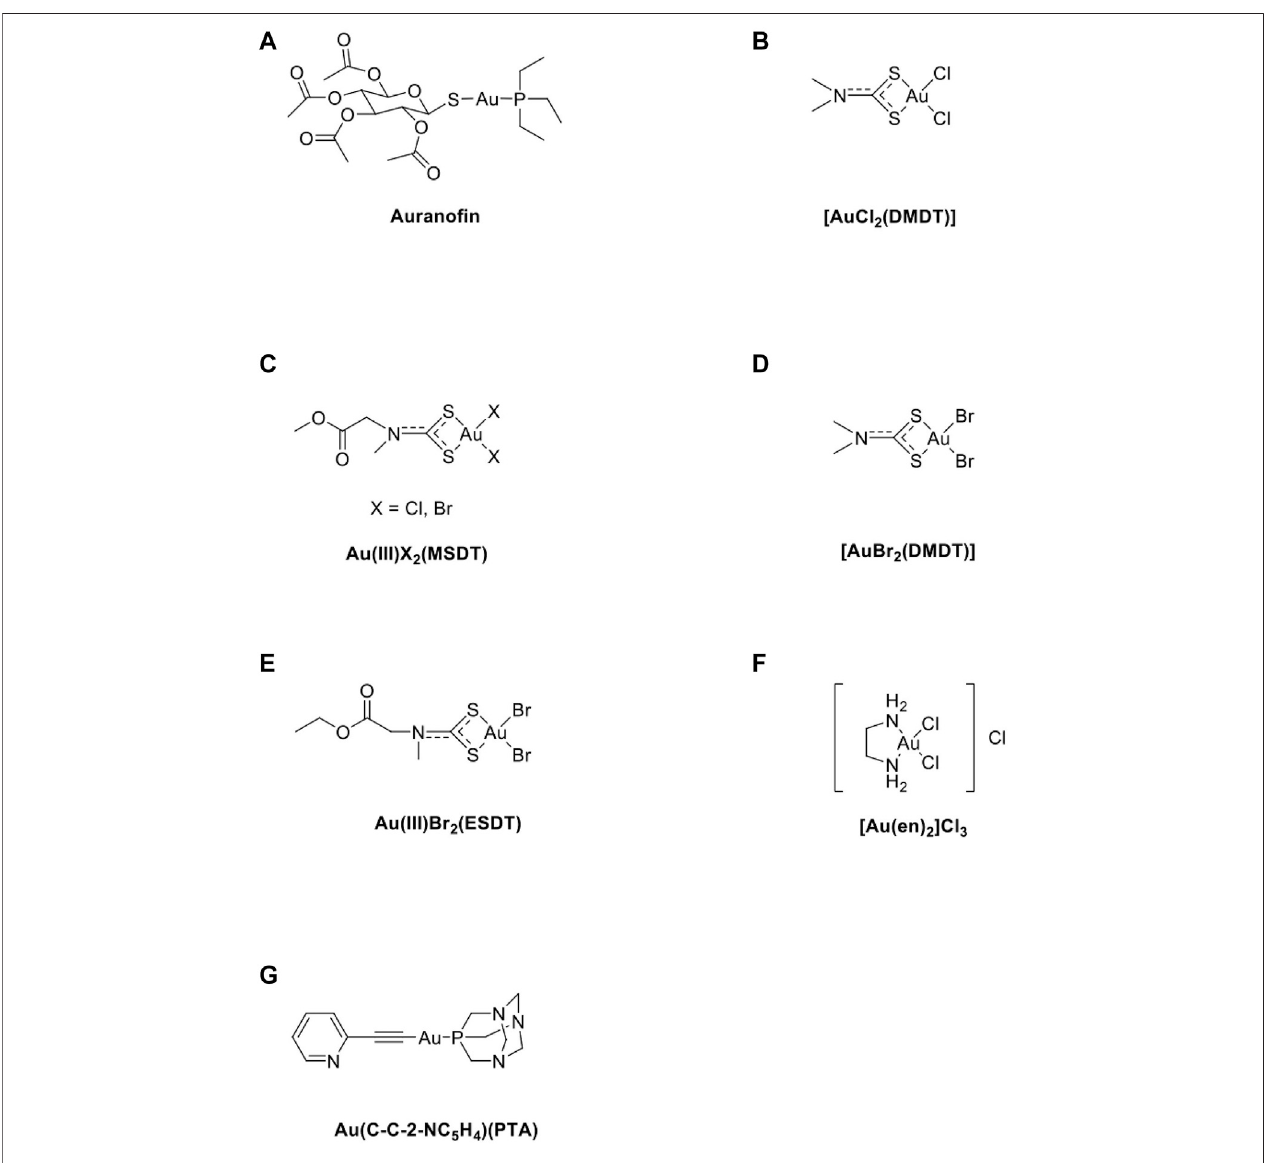
FIGURE 2 | The chemical structure of several common gold compounds. (A) Aurano fi n; (B) Au III Cl 2 (DMDT); (C) AuX 2 (MSDT) X (cid:1) Cl, Br; (D) Au(III)Br 2 (DMDT); (E) Au(III)Br2(ESDT); (F)